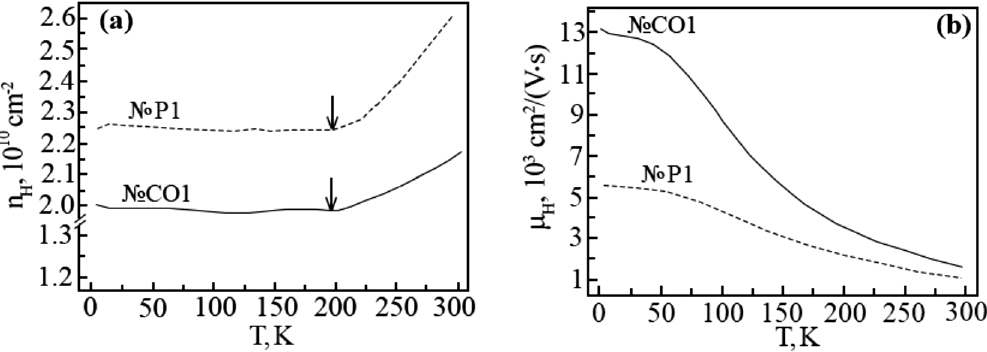
Fig. 2 Temperature dependences of the Hall concentration a and Hall mobility b of 2DEG for samples of heterostructures №CO1 and №P1. The arrows indicate the beginning of an abrupt increase in functional dependencies